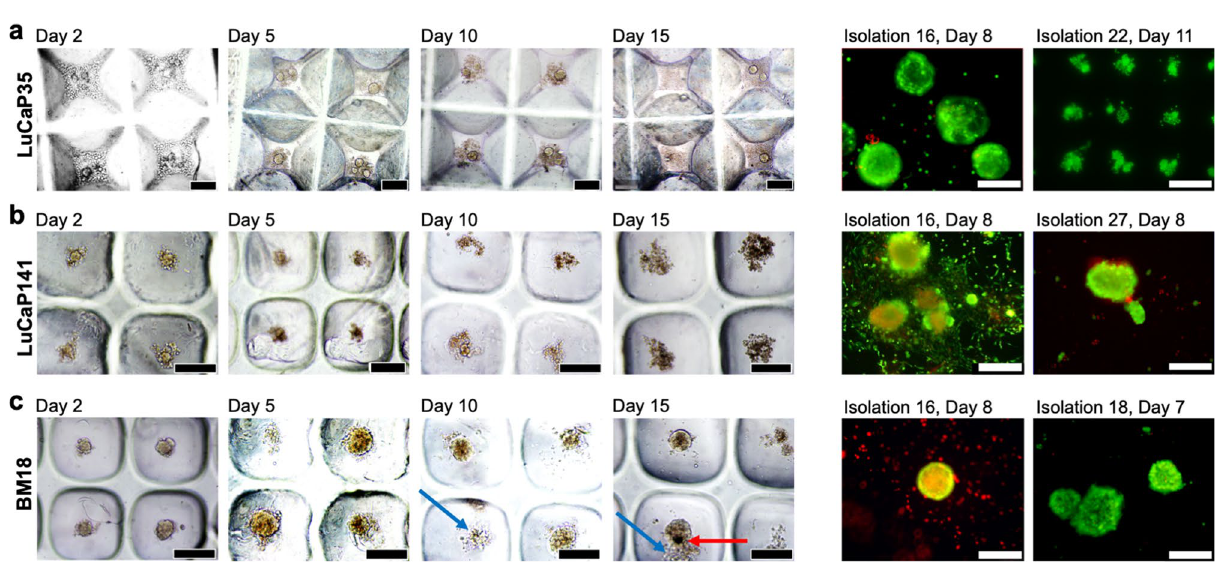
Figure 4. Mouse cell-depleted PDX PCA cells in 3D microtumour culture. ( a ) LuCaP35-derived cells formed small aggregates, sometimes requiring more than a single day to amalgamate into a single microtumour per well. ( b ) LuCaP141-derived cells were the least consistent in forming a single discrete microtumour per microwell. Frequently small clumps or loose cells would surround each microtumour. ( c ) BM18-derived cells formed the largest microtumours. While none of microtumours consistently increased in size during in vitro culture, cells did remain viable (dye Live(green)/Dead(red)) over several days. Red arrow points to a region of a microtumour that has become tightly aggregated and compacted, while the blue arrows point to cell debris that has not been incorporated into the spheroid. Scale bars = 200